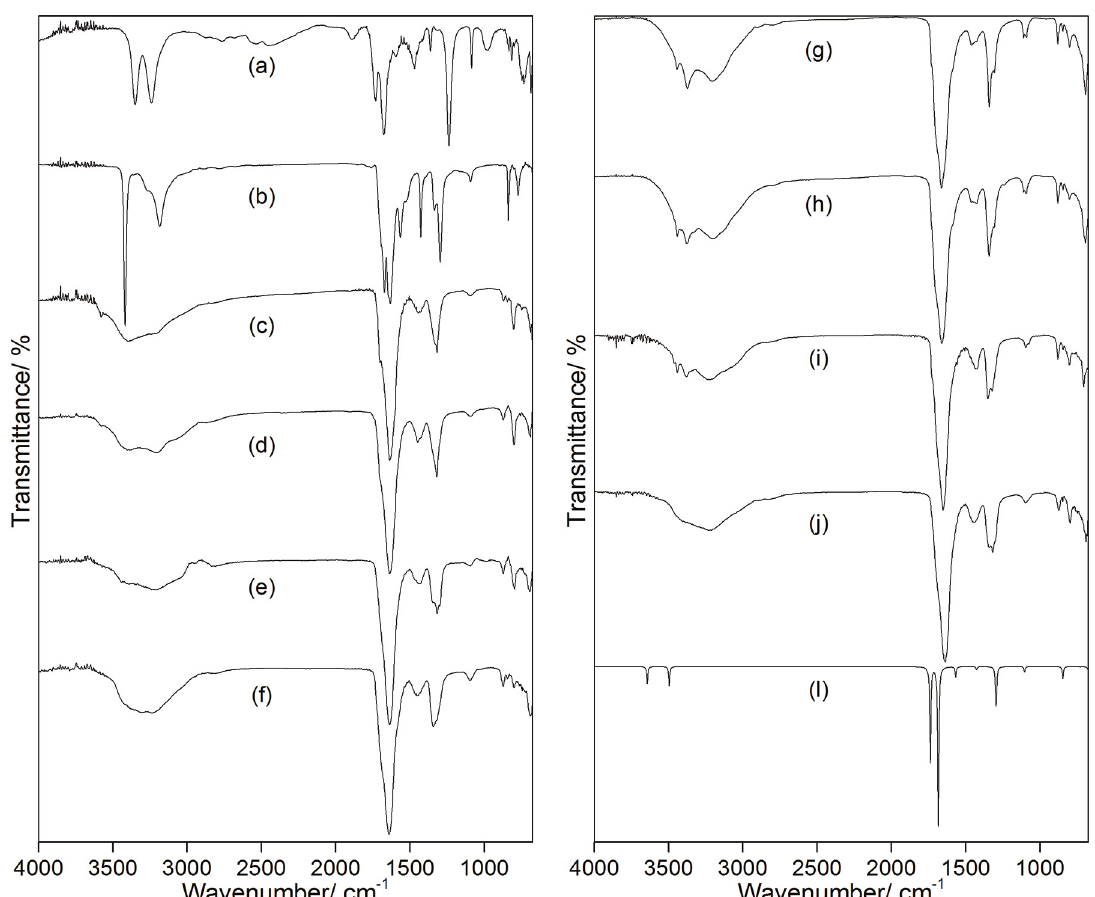
Figure 4. IR spectra of (a) oxamic acid, (b) sodium oxamate and of the complexes of: (c) Tb, (d) Dy, (e) Ho, (f) Er, (g) Tm, (h) Yb, (i) Lu, (j) Y and (l) Y